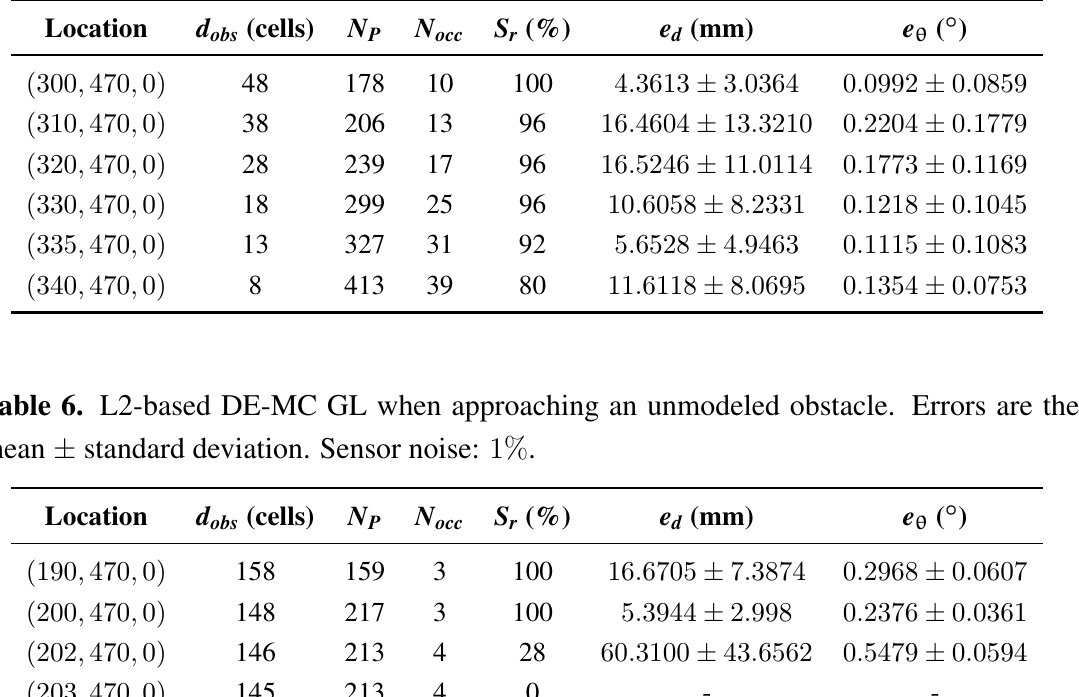
Table 5. KL-based differential evolution (DE)-MC GL when approaching an unmodeled obstacle. Errors are the mean ± standard deviation. Sensor noise: 1% .